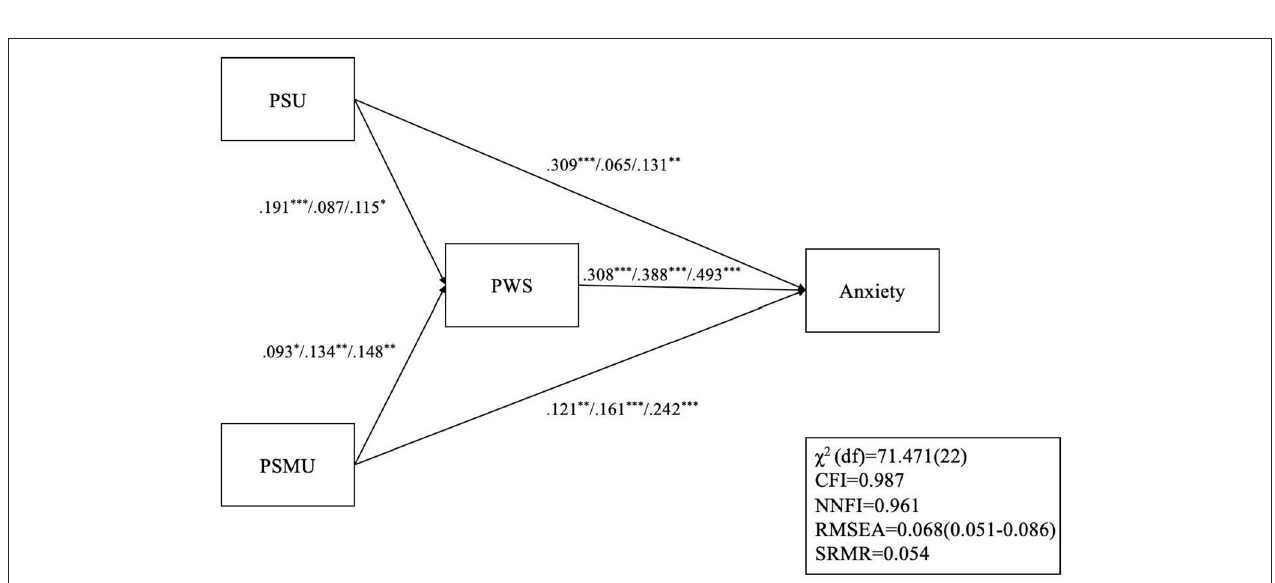
FIGURE 2 | Structural equation modeling with multiple group analysis on the relationship among PSU, PSMU, PSW, and anxiety. * p < 0.05; ** p < 0.01; *** p < 0.001; For each set of path coefficients, the first coefficient represents pre-COVID associations (Wave 1); the second coefficient represents associations during the COVID outbreak (Wave 2); the last coefficient represents post-COVID lockdown (Wave 3) associations; PSU, problematic smartphone use; PSMU, Problematic social media use; PWS, perceived weight stigma; CFI, Comparative fit index; NNFI, non-normed fit index; RMSEA, root mean square error of approximation; SRMR, standardized root mean square